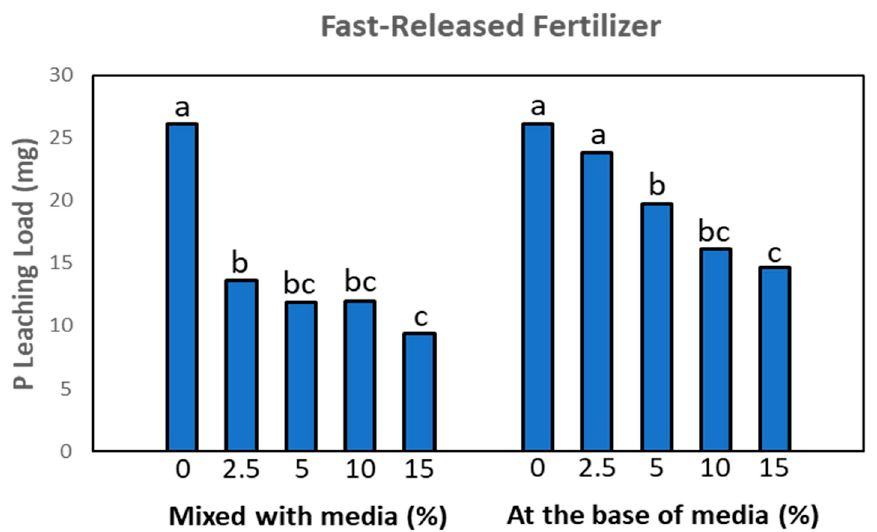
Figure 4. Mean dissolved reactive phosphorus (DRP) loading loss in leachate as affected by FGD gypsum mixed with media or placed at the bottom of containers fertilized with a fast-release fertilizer. Within each gypsum application method, bars with the same letter are not significantly different ( p < 0.05).